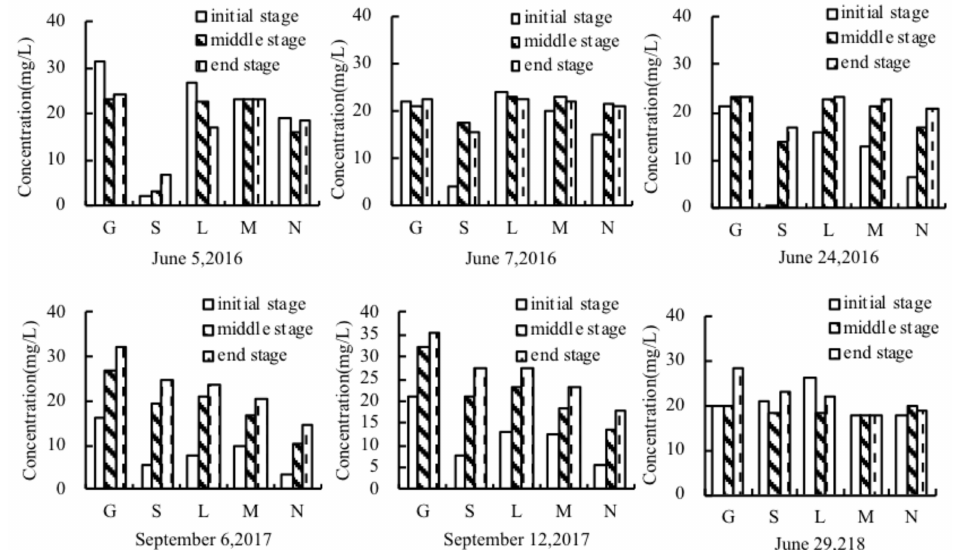
Figure 8. Observed nitrate nitrogen concentration of the subsurface drainage